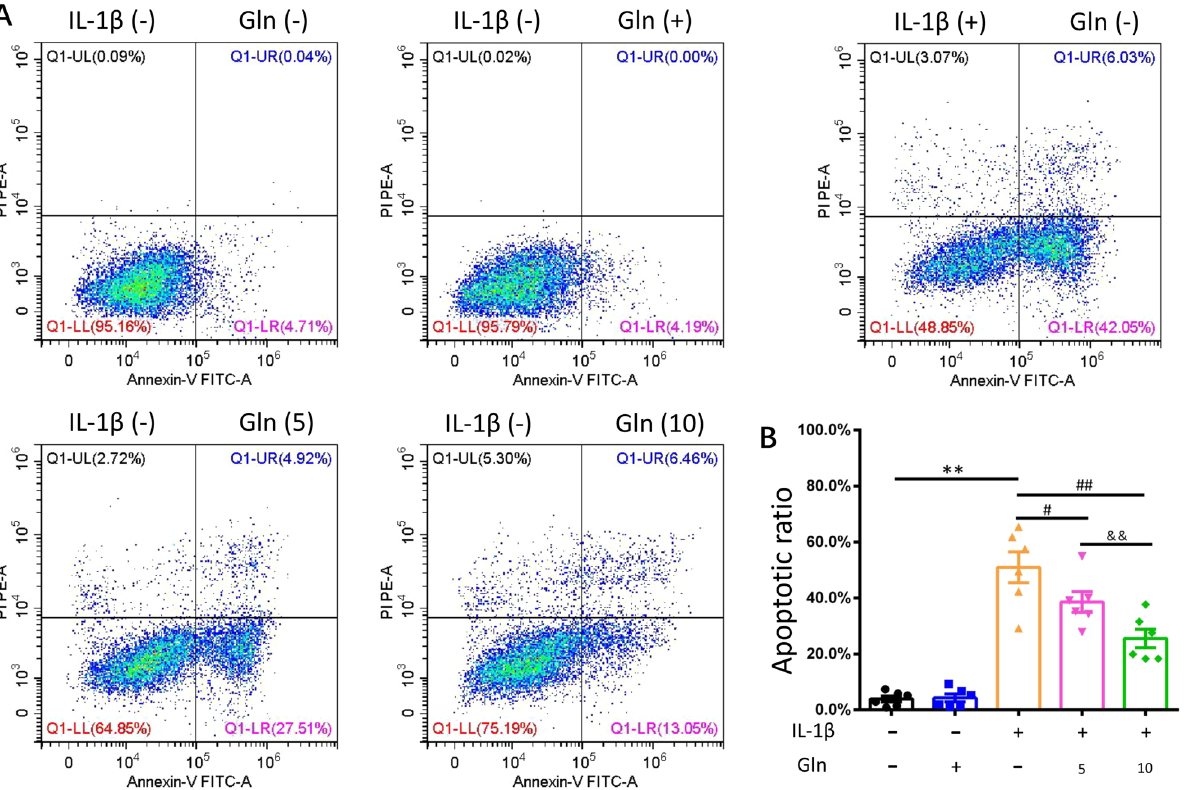
Figure 2. Effect of both concentrations of glutamine on the apoptotic ratio. The chondrocytes were cultured in 96-well plates and stimulated with IL-1β (10 ng/ml) for 24 h following treatment with both doses of